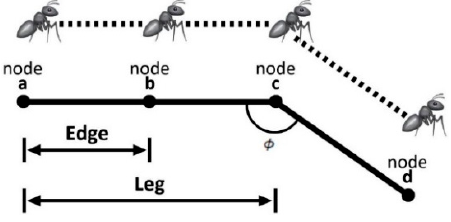
Figure 2. Nodes, Edges, and Legs.